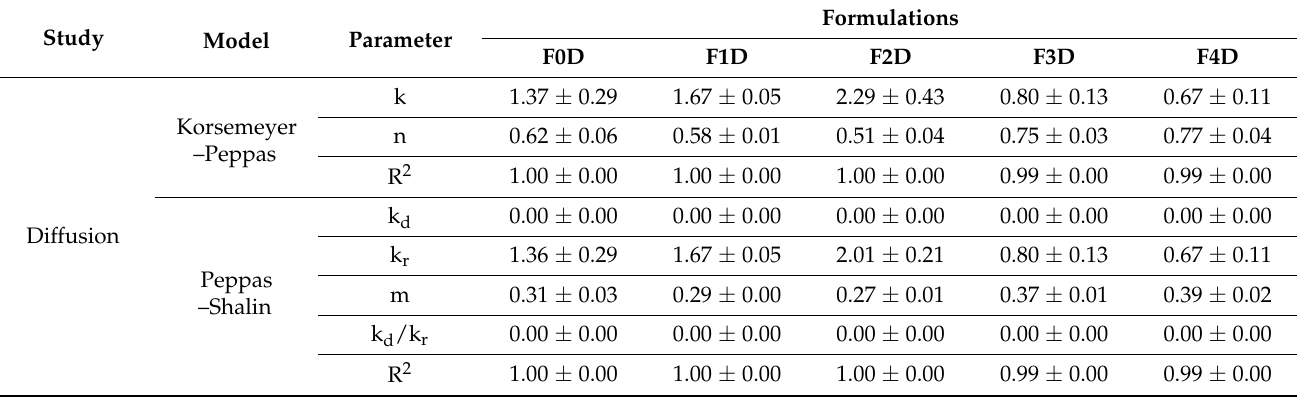
Table 5. In vitro drug release